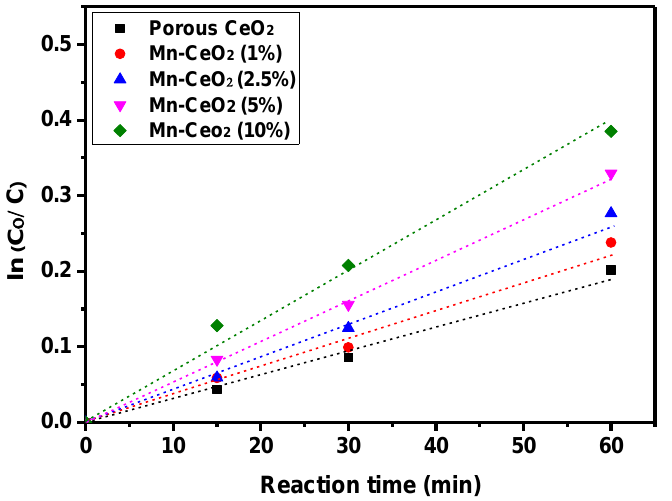
Figure 8. The pseudo first-order kinetic model is based on the obtained decolorization reaction data.